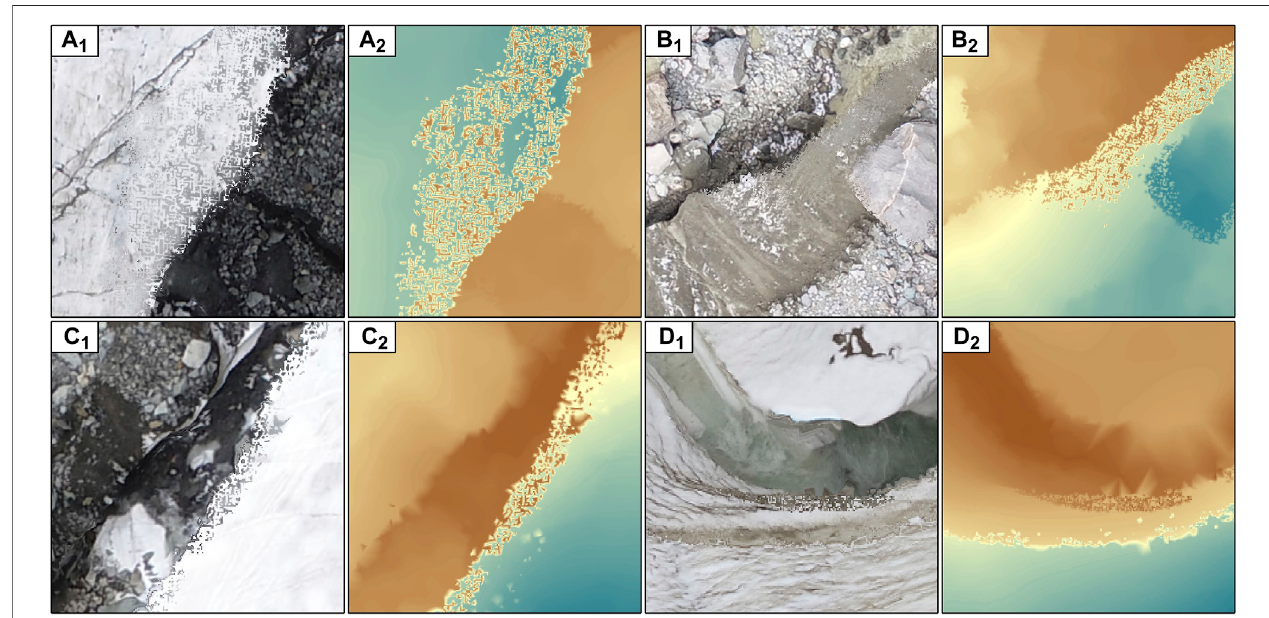
FIGURE 9| Examplesof the limitations of nadir view UAV survey in DSM generation on steep terrains, e.g. lateral river asideclean ice (A) and ice cliff (B) , as well as supra river aside (C) and on (D) clean ice. Subscript 1 is UAV image and two is DSM.